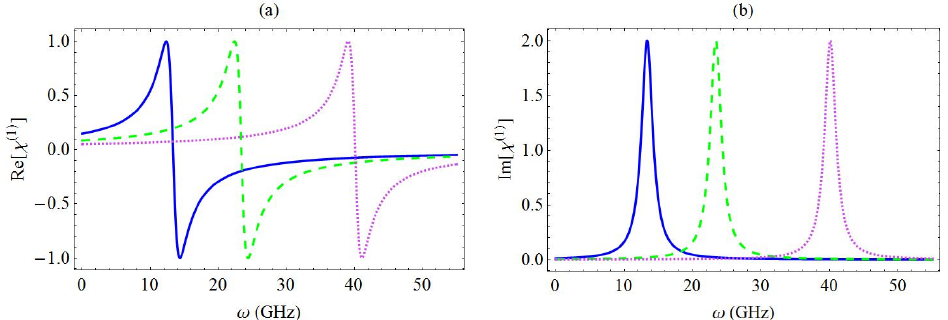
Figure 3. Spectra of the real part ( a ) and the imaginary part ( b ) of χ ( 1 ) for different values of the coupling strength between the exciton and the phonon mode: g = 5 GHz (blue solid curve), 10 GHz (green dashed curve), and 15 GHz (magenta dotted curve). In addition, ω 10 = 10 GHz.